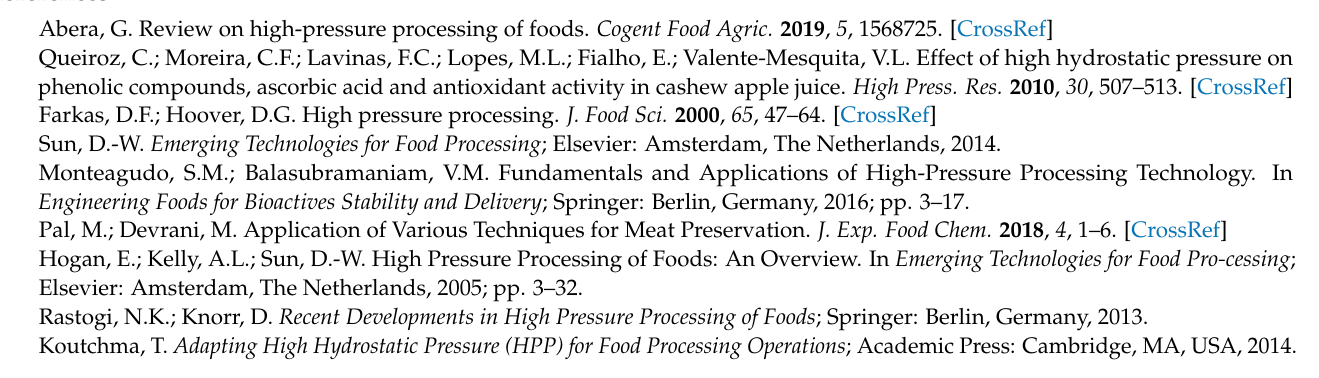
film, Figure S2: A typical pressure vs. time, and vessel temperature vs. time profile of HPP reactor when pressure is set at 600 MPa and hold time is 3 min, where before pressurisation the vessel temperature is 21 ◦ C, and 32 ◦ C when it reached 600 MPa, Figure S3: Structures of the deprotonated (red) and protonated (blue) congo red, Figure S4: UV/vis absorption spectra of the CR ink film in ambient air and interference bands, α = 0 to 6 are numbered and highlighted by the broken red lines, Figure S5: Plot of interference data from Figure S4 in the form of α /2 vs. n f / λ . The gradient (=2b) of the line of best fit is 109.5 µ m, thus, b = 54.8 µ m for the CR ink film, Figure S6: UV/vis absorption spectra of the clear PET film and interference bands, α = 0 to 4 are numbered and highlighted by the broken red lines, Figure S7: Plot of interference data from Figure S6 in the form of α /2 vs. n f / λ . The gradient (=2b) of the line of best fit is 103.6 µ m, thus, b = 51.8 µ m for the clear PET